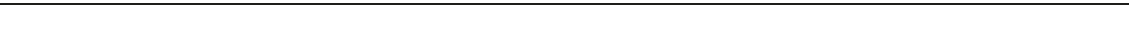
Fig. 1 BLM is recruited to AsiSI-induced DSBs. a BLM and γ H2AX colocalize after DSB induction. U2OS – AsiSI – ER cells were grown asynchronously ( − 4- OHT) or in the presence of + 4-OHT for 4 h. Cells were fi xed and stained with anti-BLM and anti- γ H2AX antibodies. Nucleus was stained by DAPI. Bar, 5